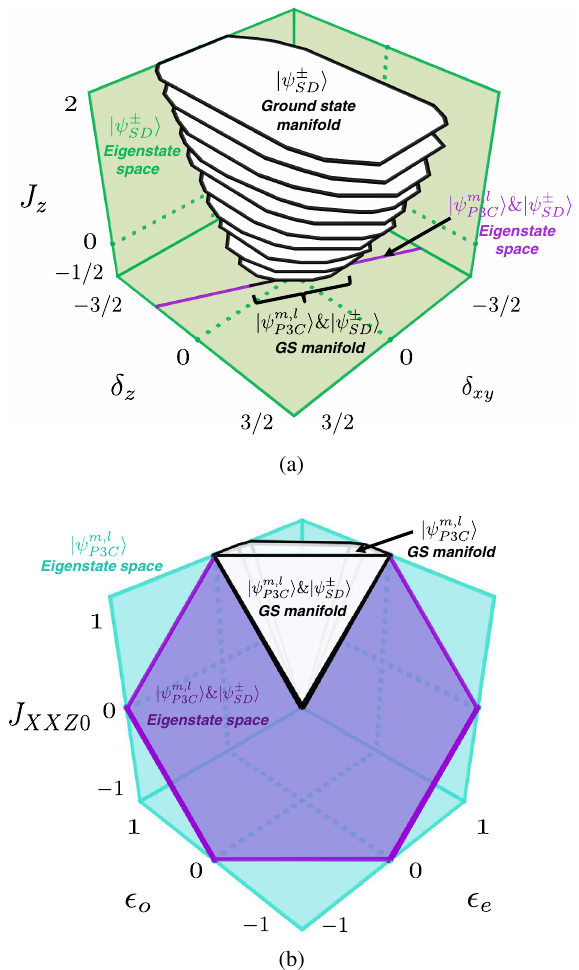
FIG. 5. State collision example. Collision of the singlet dimer states j ψ (cid:2) SD i and the projected three-coloring states j ψ m;l P 3 C i from (a) the perspective of the singlet dimer eigenstate space, which is given by Eq. (7) with J xy ¼ 1 and is shown in green, and (b) the perspective of the projected three-coloring eigenstate space, which is given by Eq. (8) and is shown in teal. The space where all of the states are degenerate eigenstates is given by Eq. (6) and is shown in purple; it appears as a line in (a) and a plane in (b). The collision region, where all states are degenerate ground states, occurs on the indicated line segment in (a) and in the indicated triangular region in